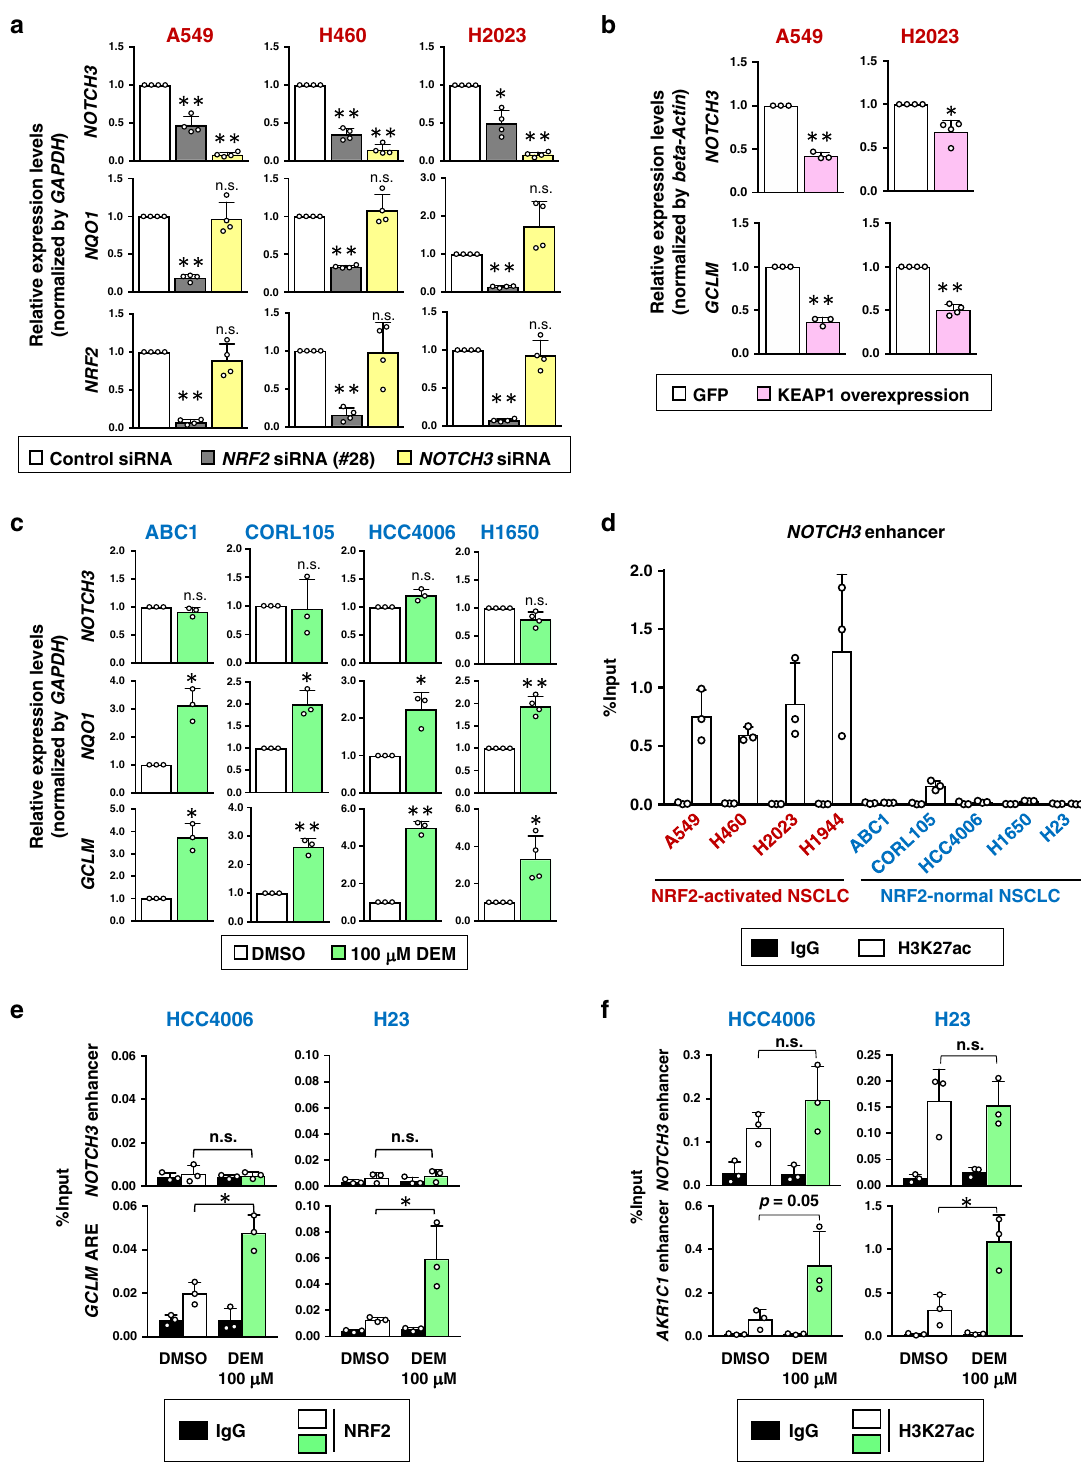
Cooperative chromatin binding of NRF2 and CEBPB generates NOTCH3 enhancer in NRF2-activated NSCLCs . The NOTCH3 enhancer region was found to be bound by seven transcription factors, including CEBPB, in A549 cells according to the ENCODE ChIP-seq data (Fig. 8a) and contained consensus binding sites for eight transcription factors, among which those for NRF2/FOSL2 and CEBPB were conserved in the human and mouse (Fig. 8b). Knockdown experiments in A549 cells revealed that CEBPB and FOSL2 made a substantial